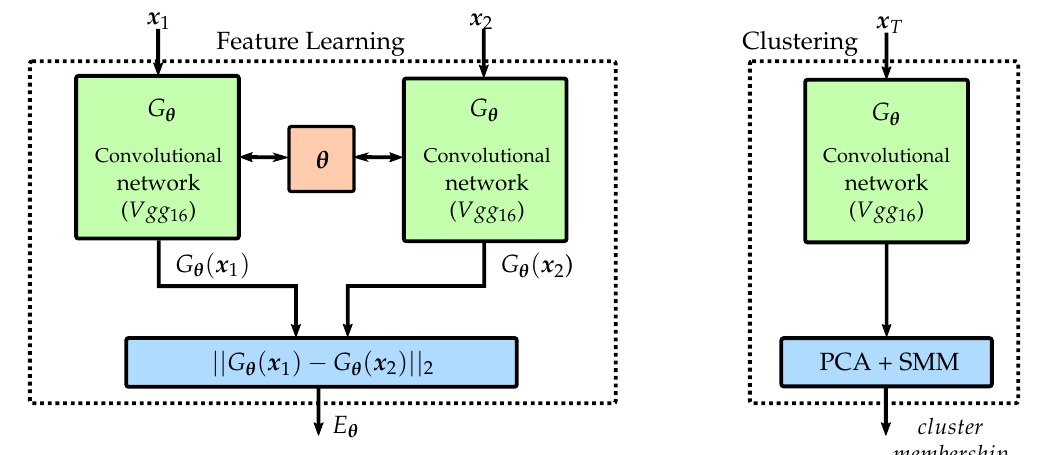
Figure 3. Supervised feature learning and unsupervised clustering. Source: [26] (CC BY